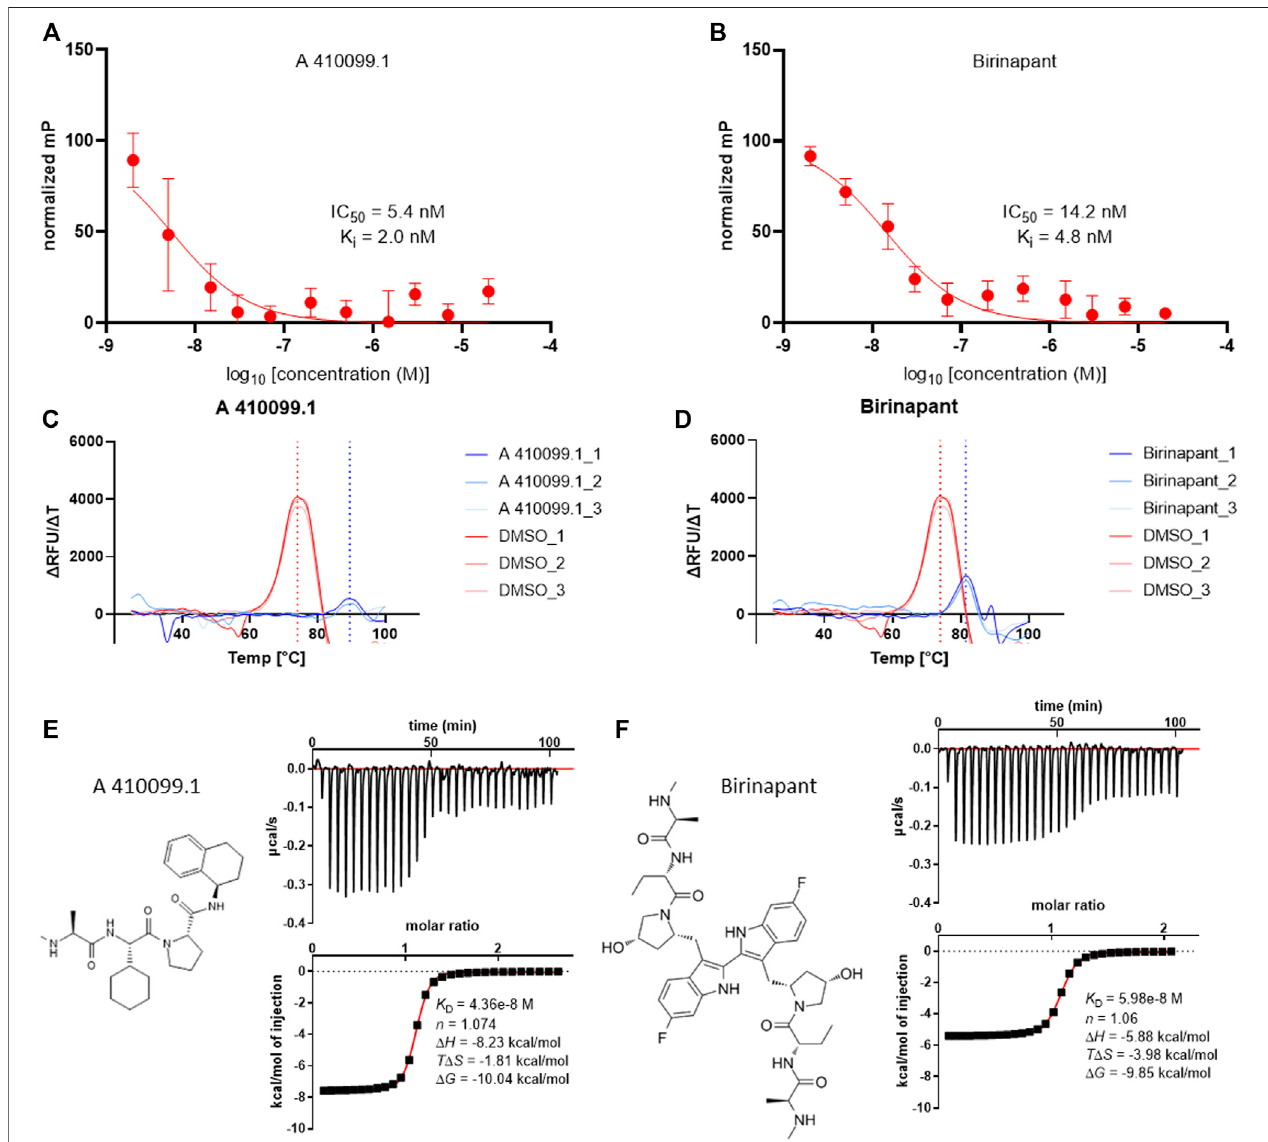
FIGURE 2 | Exemplary results of the biophysical assays performed on the BIR3 domain of BIRC2. (A) and (B) FP assay curves of the compound titrations Data were expressed asmean ± SD ( n = 3). (A) titration curve ofA 410099.1withan estimated IC 50 of 5.4 nM and the calculated K I of2.0 nM. (B) titration curveof Birinapant with an estimated IC 50 of 14.2 nM and the calculated K I of 4.8 nM. (C) and (D) Δ RFU/ Δ T plotted against the temperature obtained from DSF ( n = 3). (C) melting point determinationforA410099.1(bluedottedline)incomparison totheDMSOcontrol(reddottedline). (D) melting pointdeterminationforBirinapanttreatedproteinin comparison tothe DMSO control. (E,F) ITC results of A410099.1and Birinapant with µcal/s plotted against the time in theupper frame and kcal/mol of injection plotted against the molar ratio in the bottom frame with a K D , n, Δ H, T Δ S and Δ G given ( n =